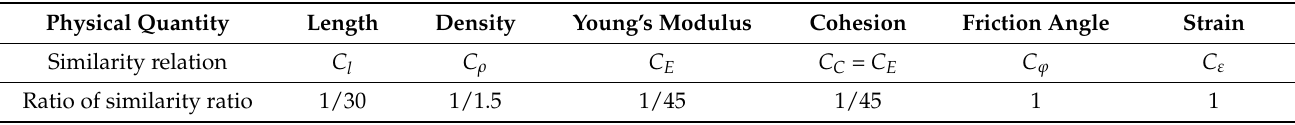
Table 1. Similarity relation for shaking table tests.